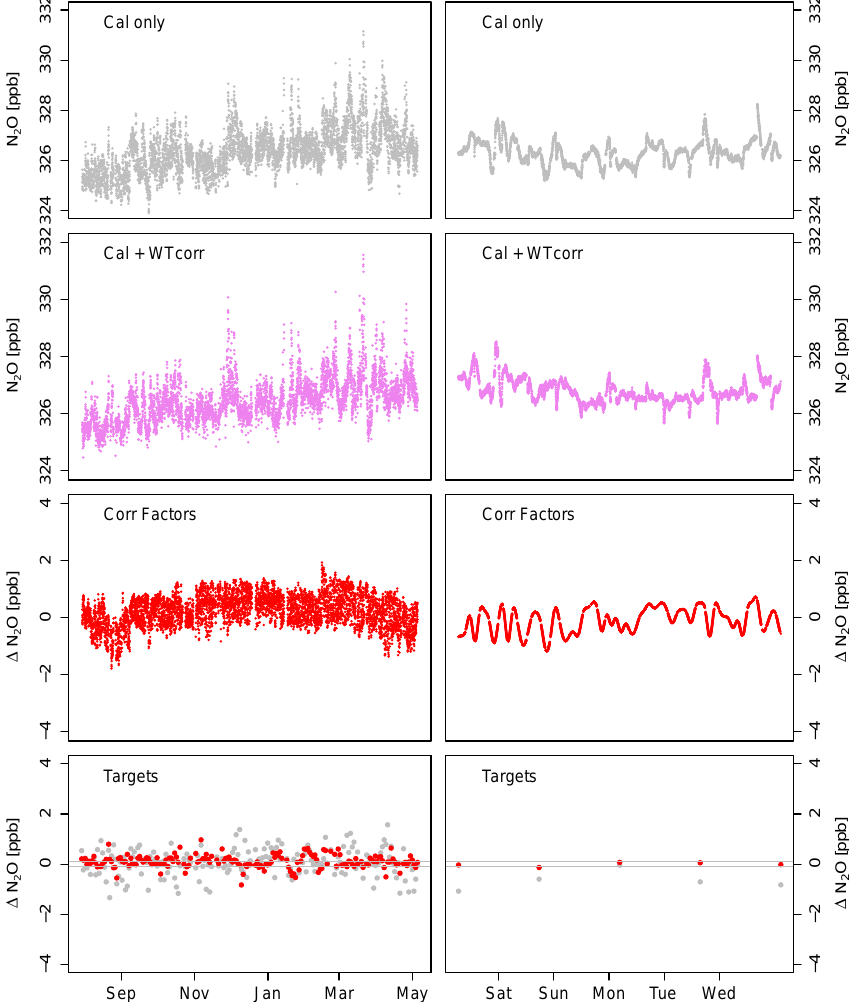
Figure 8. Detail of the working tank correction for the OA-ICOS instrument, showing the correction process for the entire time series (left) and an arbitrarily selected week (right) for N 2 O only. In the first row, N 2 O is shown with only calibrations applied (“Cal only”). In the second row, a drift correction based on the working tank measurements has been applied to the calibrated data (“Cal + WTcorr”). In the third row, the correction factors that were used to produce the data in the second panel are shown (“Corr Factors”). These are determined by calculating the difference between each working tank measurement and the average of all working tank measurements and fitting a curve to groups of consecutive working tank measurements with no gaps (i.e., every 2h). In the fourth panel, target measurements (“Targets”) are shown using the calibrated only data (grey points) and the drift corrected and calibrated data (red